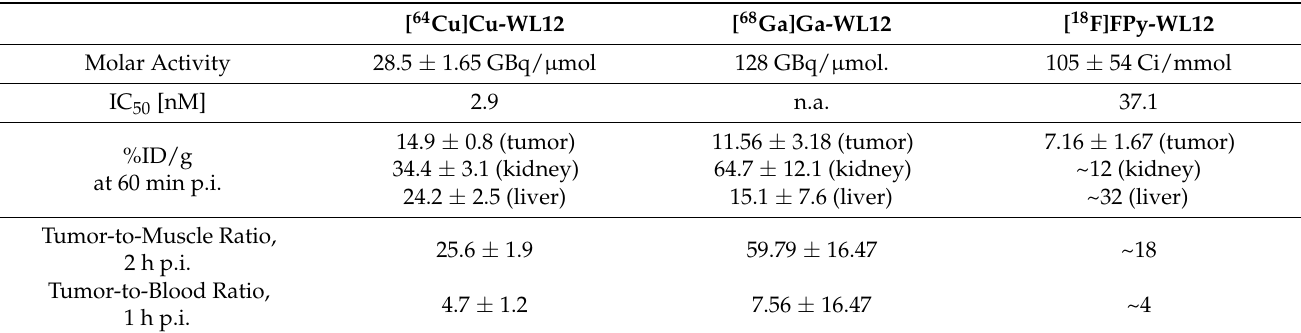
Table 2. Comparison of the radiochemical, in vitro, and in vivo properties of all three WL12